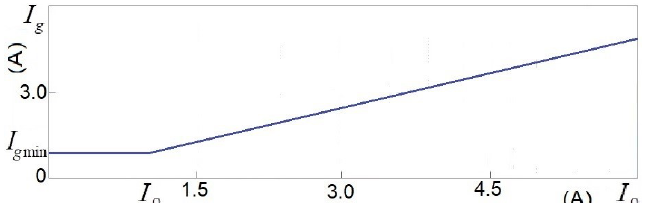
Figure 8. Software-OCC, I g vs. I 0 , Equation (34), with a minimum value, I gmin = 1, V Sg = 110 V and = 467 V. V ∗ 0